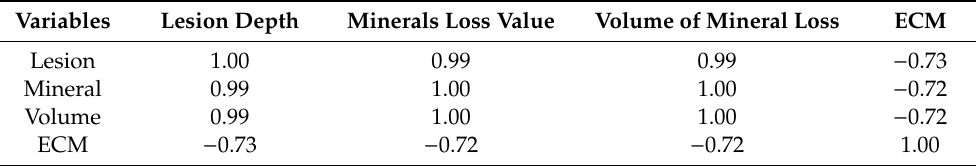
Table 4. Association of electronic carries monitor (ECM) with microradiography data of enamel (Pearson’s correlation